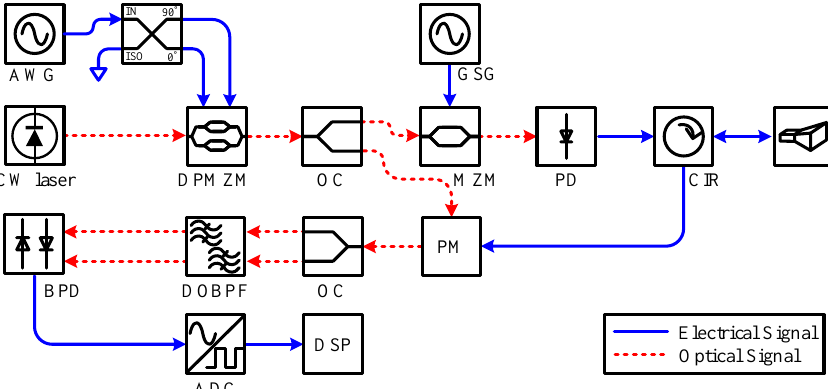
Figure 1. The proposed photonic-based pulsed radar architecture. AWG: Arbitrary waveform generator, GSG: Gating signal generator, CW laser: Continuous-wave laser, DPMZM: Dual-parallel Mach-Zehnder modulator, OC: Optical coupler, MZM: Mach-Zehnder Modulator, PD: Photodetector, CIR: Circulator, BPD: Balanced photodetector, DOBPF: Dual Optical Bandpass filter, PM: Phase